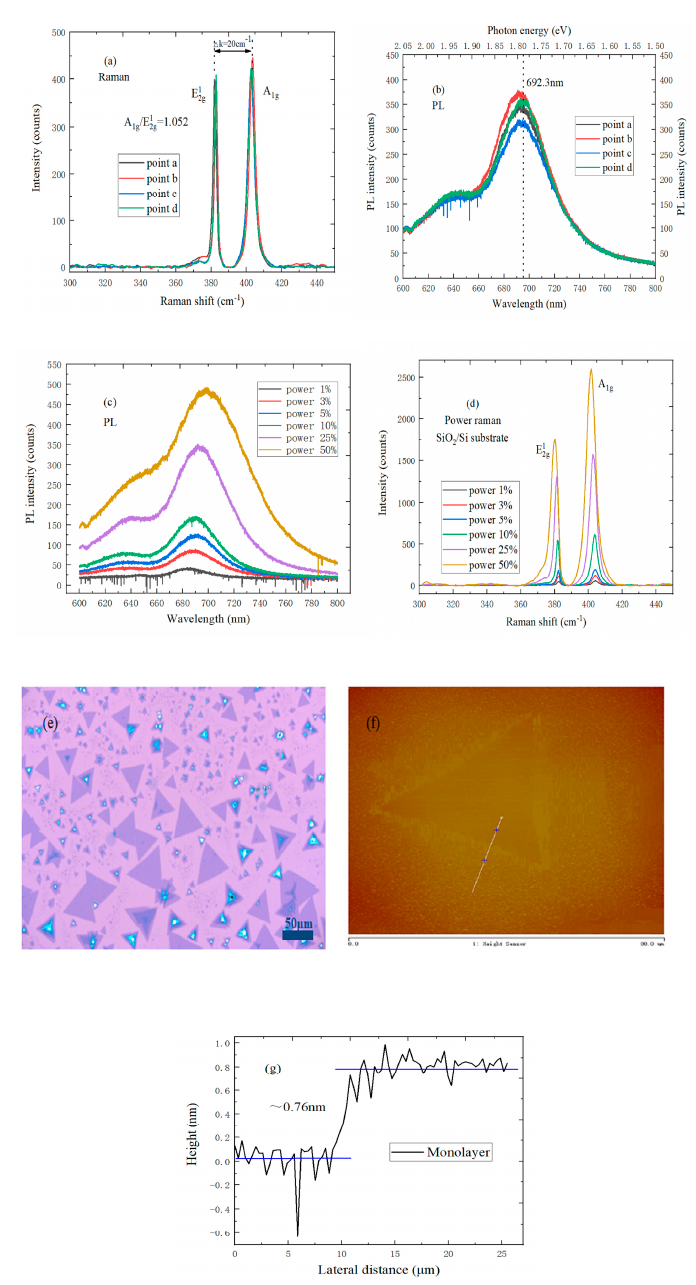
Figure 3. ( a ) Raman spectrum of four di ff erent points in monolayer MoS 2 on a SiO 2 / Si substrate; ( b ) PL spectrum of four di ff erent points in monolayer MoS 2 on a SiO 2 / Si substrate; ( c ) PL spectrum of monolayer MoS 2 on a SiO 2 / Si substrate with di ff erent laser power; ( d ) Raman spectrum of monolayer MoS 2 on a SiO 2 / Si substrate with di ff erent laser power; ( e ) Optical micrograph of monolayer MoS 2 on a SiO 2 / Si substrate; ( f ) AFM morphology of monolayer MoS 2 on a SiO 2 / Si substrate; ( g ) Height profile of monolayer MoS 2 on a SiO 2 / Si